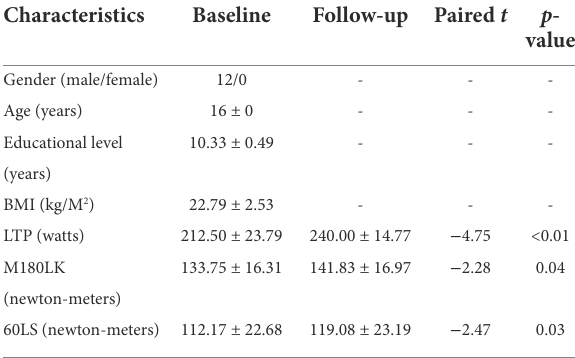
TABLE 1 Demographic characteristics and athletic performance of male rowing athletes between baseline and follow-up.